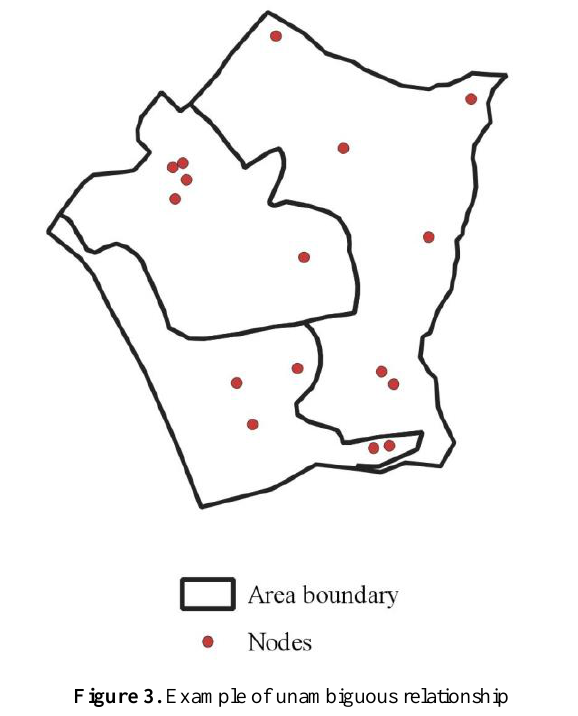
Figure 3. Example of unambiguous